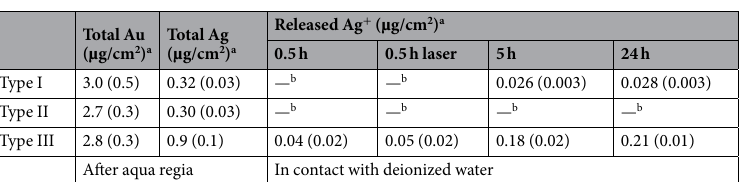
Total Ag ( µ g/cm 2 ) a